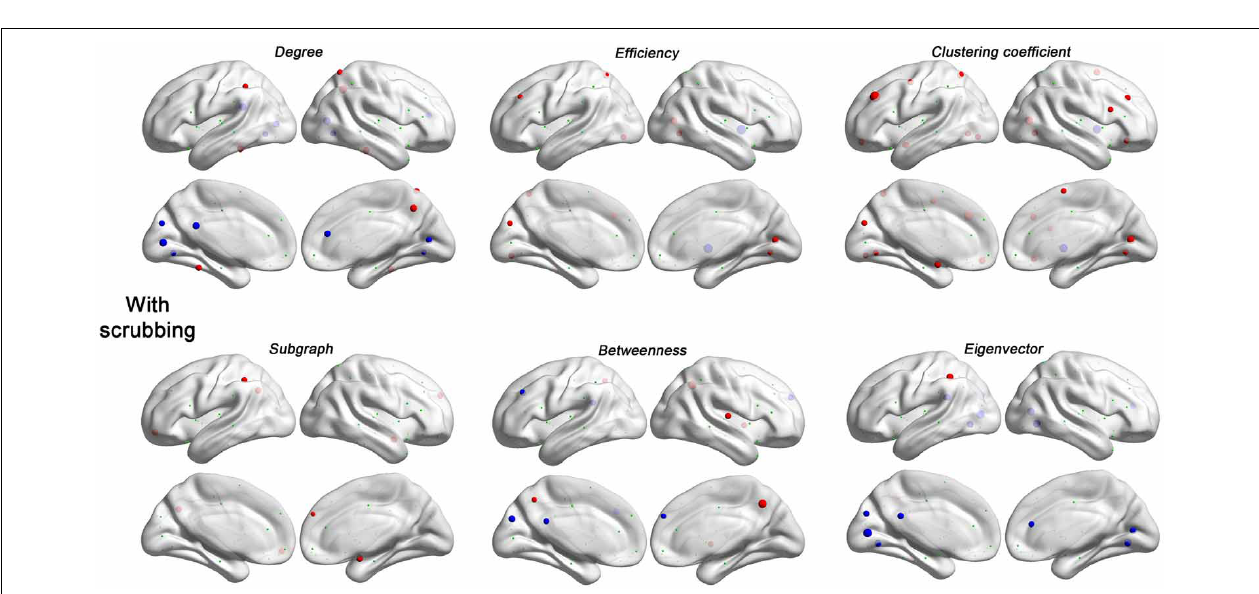
FIGURE 6 | Head motion impact on six regional topological properties with scrubbing (Friston 24 + scrubbing) at FD (Power) > 0.2mm. The regional properties were characterized by the area under the curve (AUC) of each measure integrated within density range of 0.06–0.44. The head motion